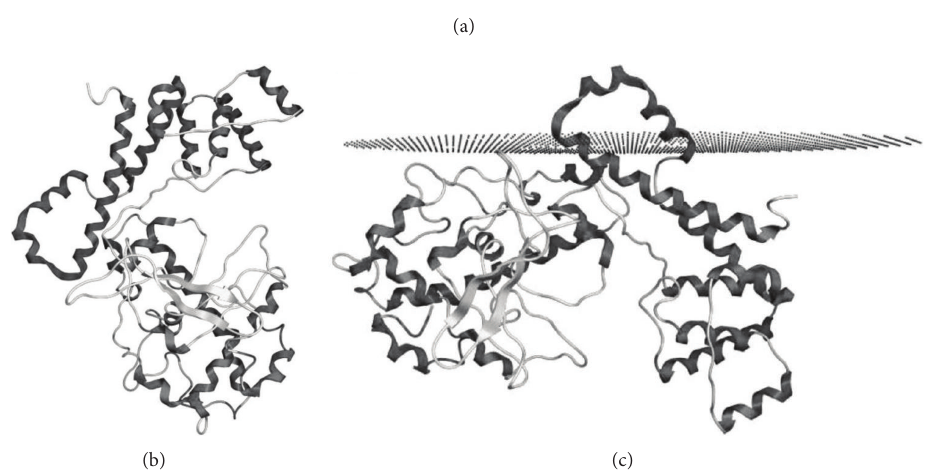
Figure 1: Predicted de novo structure of novel freeze responsive protein, FR47. (a) The secondary and (b) 3-dimensional structures of FR47 were determined using I-TASSER webserver, followed by model optimization using MOE. (c) Membrane interactions of FR47 with the intracellular membrane (represented as dots), as predicted using the PPM webserver and visualized with MOE.